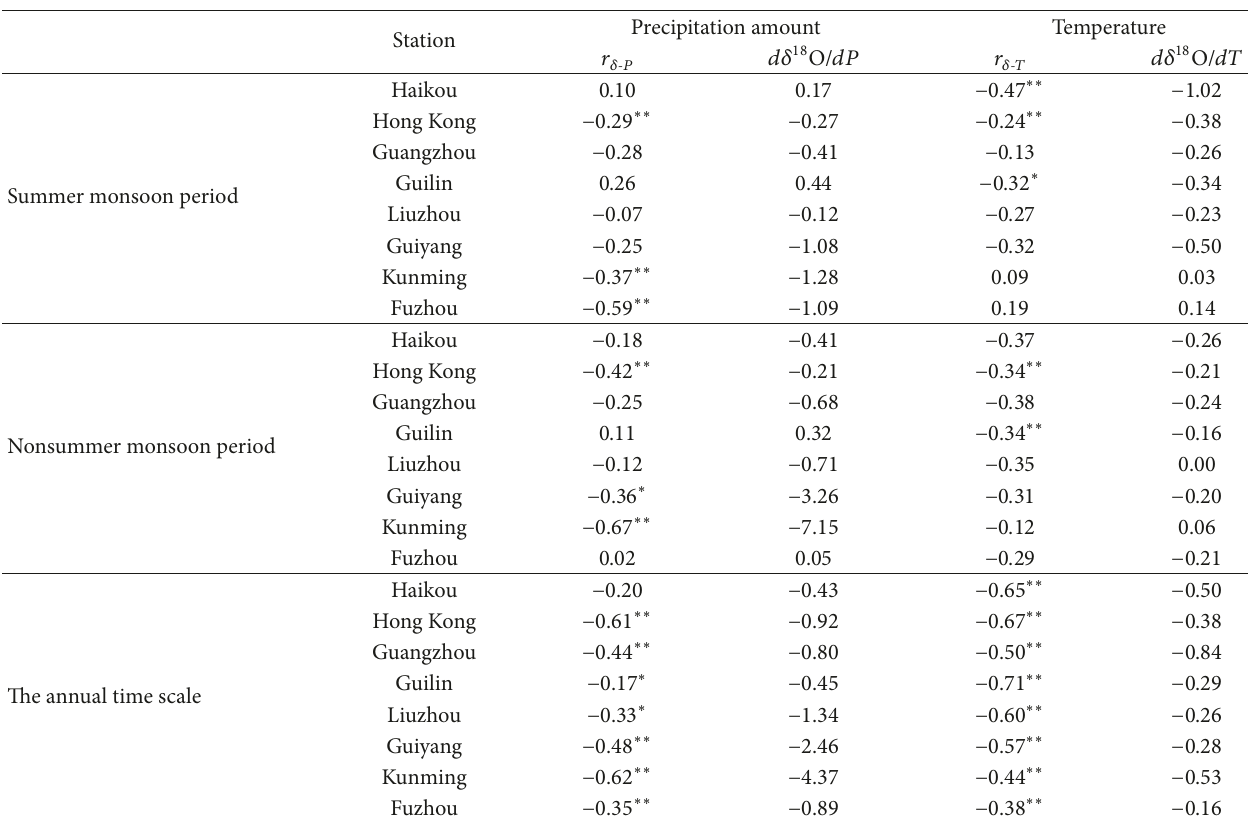
Table 2: Correlations of monthly precipitation 𝛿 18 O values at different stations with precipitation amount and temperature for three time periods in different stations of the PRB and adjacent regions. Note: ∗ and ∗∗ are represent the correlations at 𝑃 values < 0.01 and 0.05, respectively. The units of 𝑑𝛿 18 O/ 𝑑𝑃 and 𝑑𝛿 18 O/ 𝑑𝑇 are 100 mm and 1 ∘ C,